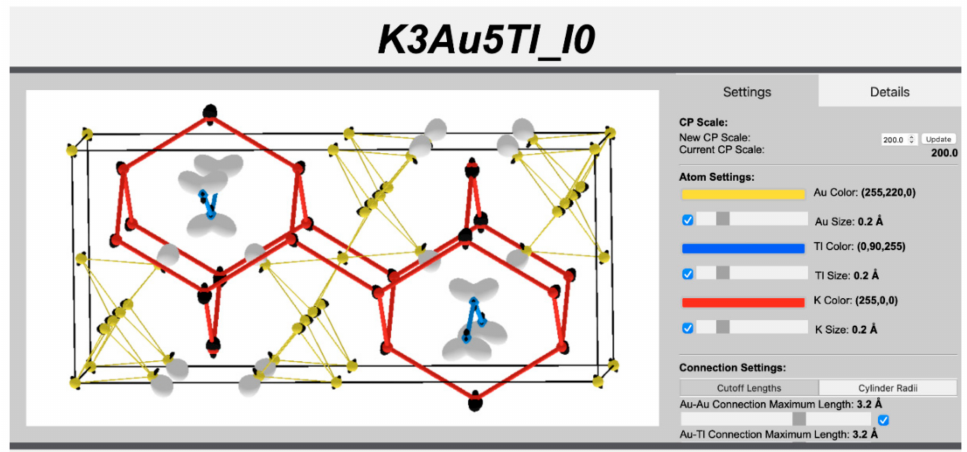
Figure 8. Adjustment of the atom colors in the FigureToolWeb plot of the K 3 Au 5 Tl CP scheme to match those in Figure 1.